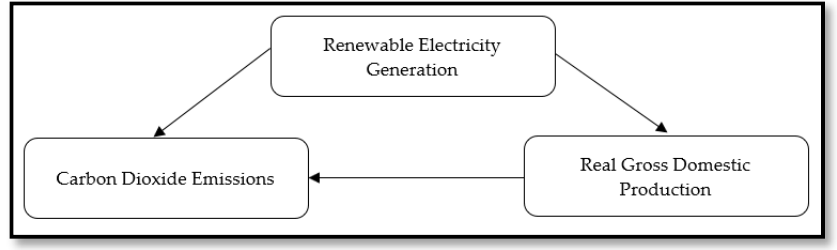
Figure 2. Long-run restrictions.